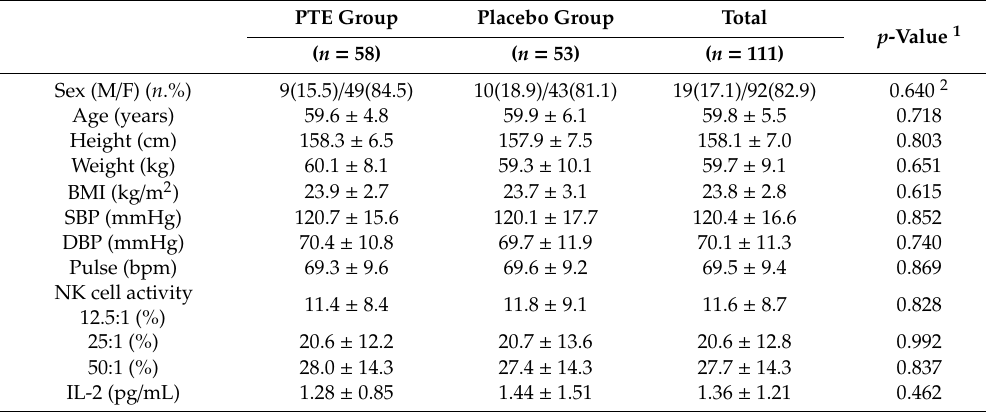
Table 2. Baseline general characteristics of the